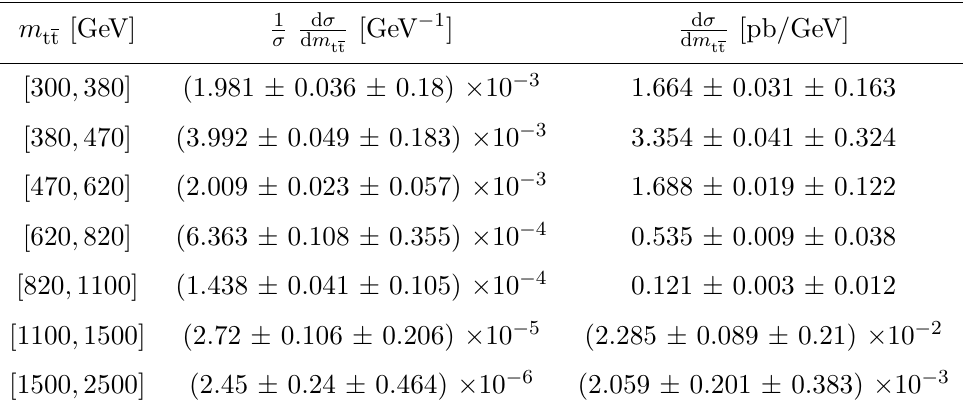
Table 12 . The measured di(cid:11)erential cross section and bin boundaries for each bin of the normalized and absolute measurements of the tt di(cid:11)erential cross section at parton level in the full phase space as a function of m are tt